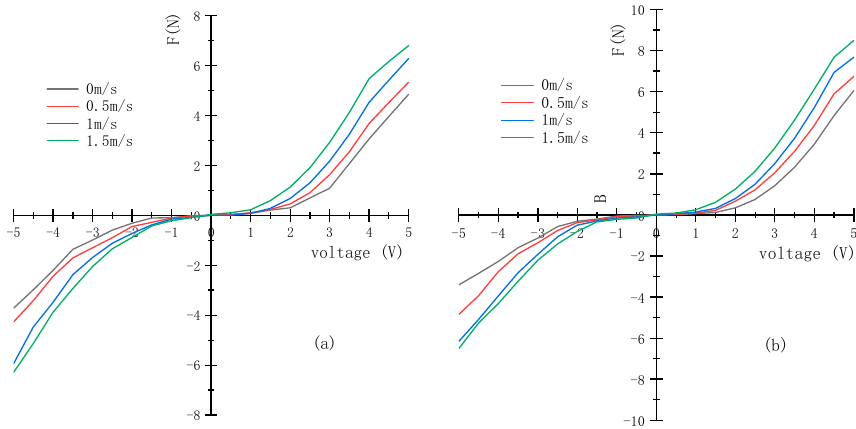
Figure 5. Thrust curves of some thrusters at different currents. ( a ): the left horizontal thruster thrust curve. ( b ): the right horizontal thruster thrust curve.